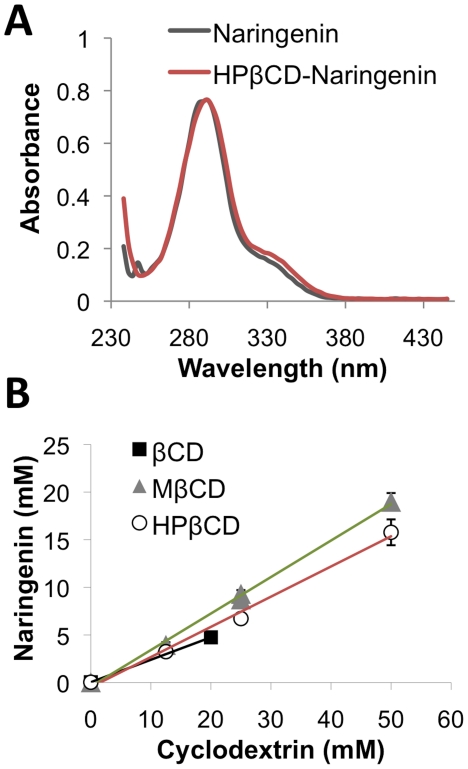
Cyclodextrins enhance the solubility of naringenin.(a) Complexation of naringenin with cyclodextrins resulted in minimal shift in the compound UV absorption spectrum. (b) Naringenin solubility in water was measured to be 36±1 µM, whereas its soluble fraction increased with the addition of βCD, mβCD, or HPβCD by 132-fold, 526-fold, and 437-fold, respectively.